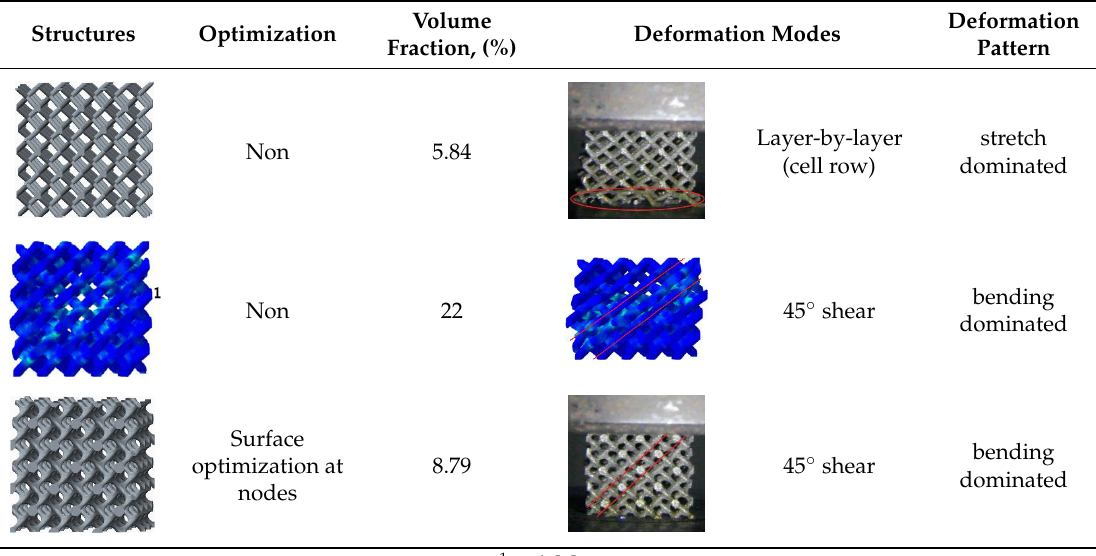
Table 6. Failure mechanism comparison with previous article.